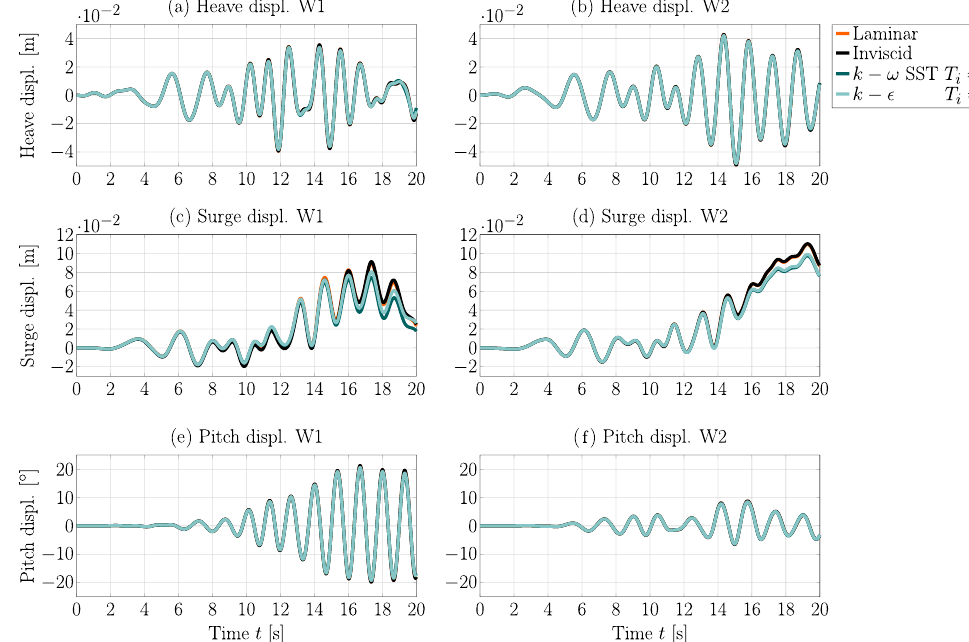
Figure 13. Time trace of the heave, surge, and pitch displacement of WEC structures ( a , c , e ) W1 and ( b , d , f )